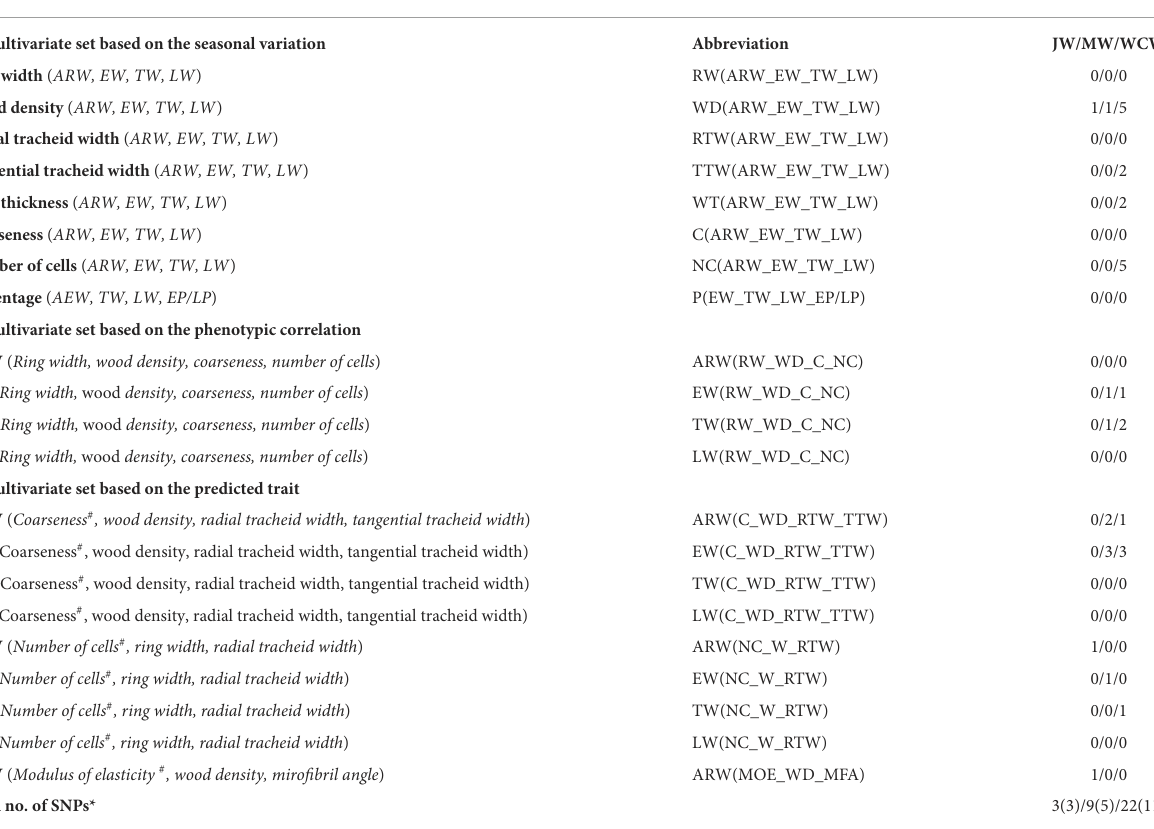
TABLE 2 List of 21 multivariate sets used for multivariate GEMMA (MV-GEMMA), their abbreviations, and the number of independent SNPs detected using MV-GEMMA. Phenotypic